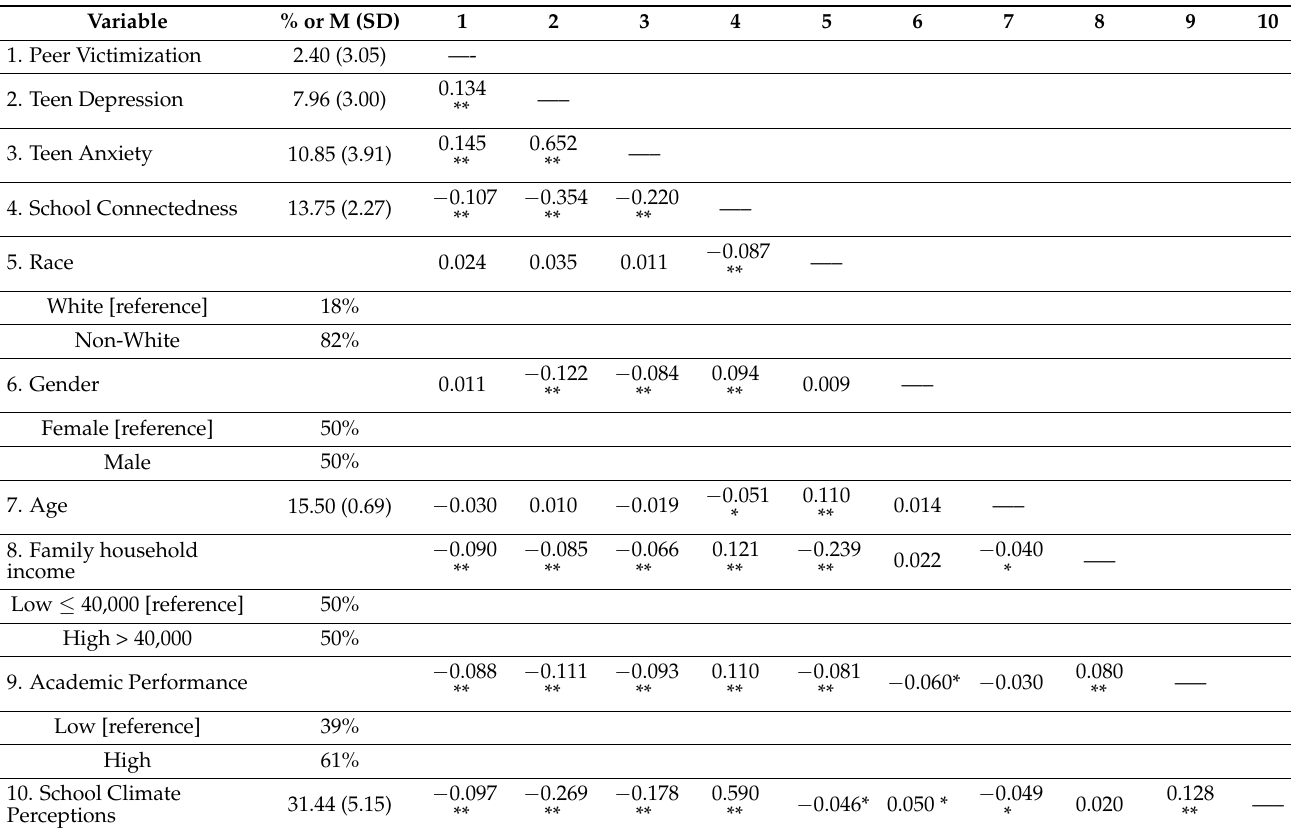
Table 1. Descriptive statistics and correlations among variables ( n =